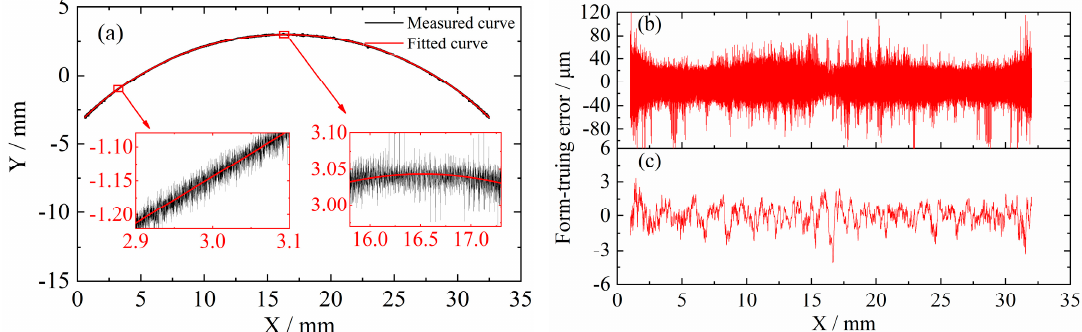
Figure 11. Surface profile of the form-trued spherical diamond wheel: ( a ) measurement results and data fitting, ( b ) original form error signals, ( c ) 3D form-truing error after low-pass filtering.